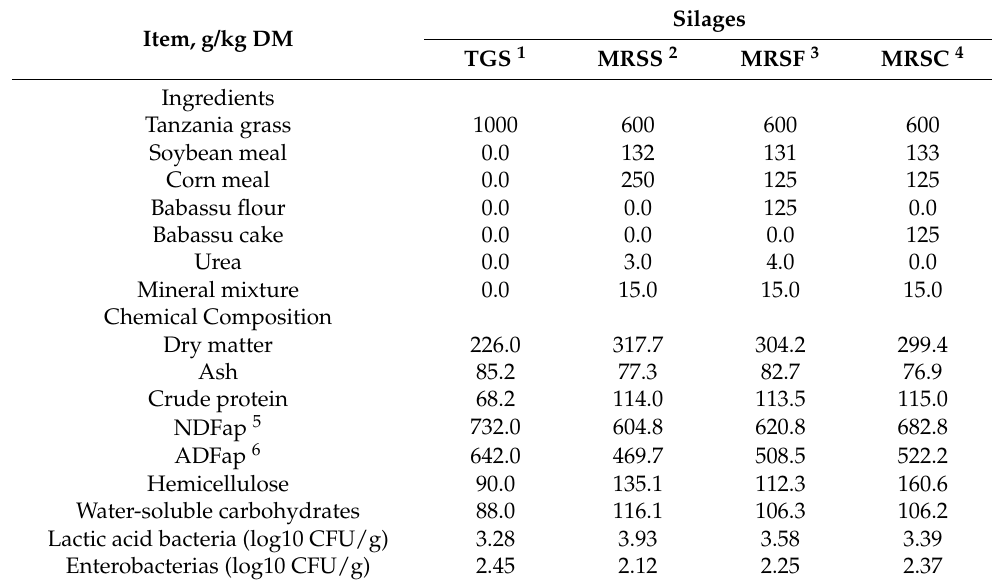
Table 2. Chemical composition and microbial count of diets at the time of